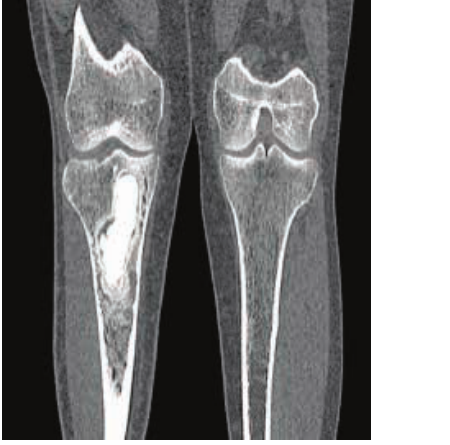
Figure 8: CT-scan of the proximal tibia at 8 weeks demonstrating progressive resorbtion of the CERAMENT and early replacement with new bone.